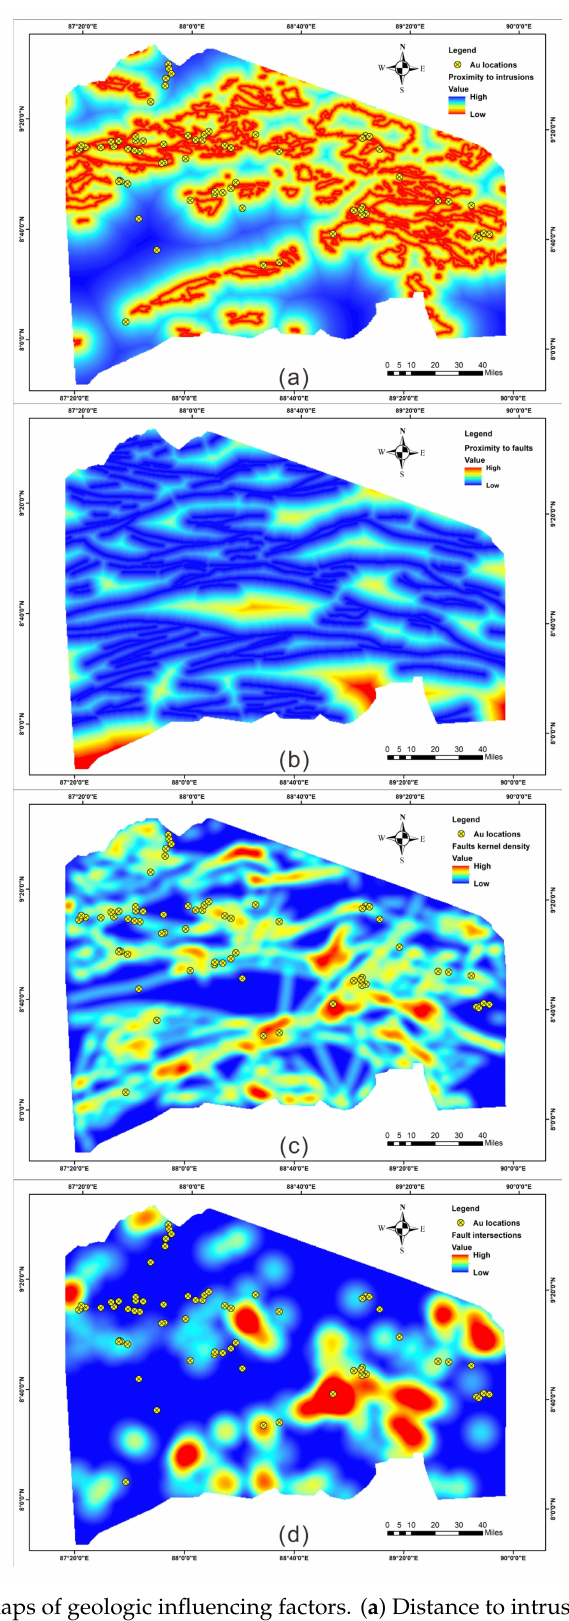
Figure 2. Predictor maps of geologic influencing factors. ( a ) Distance to intrusions; ( b ) proximity to faults; ( c ) fault kernel density; and ( d ) faults